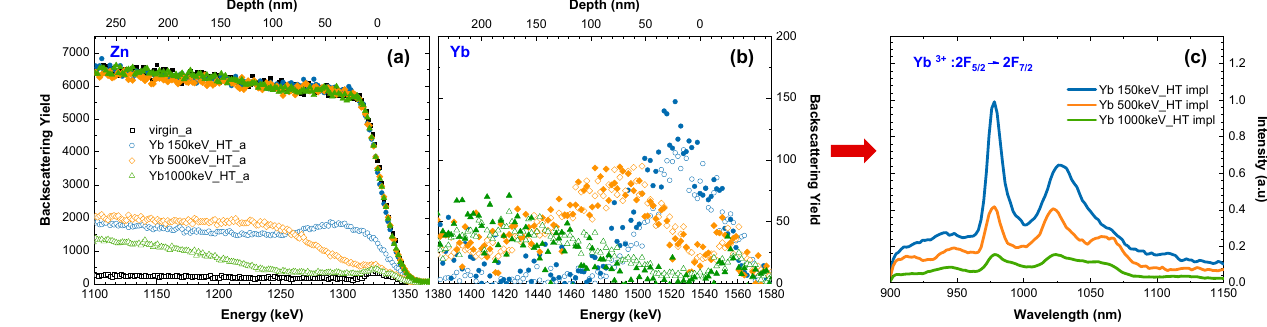
Figure 4. Random (solid symbols) and aligned (open symbols) RBS spectra ( a , b ) obtained for ZnO implanted with different energies of Yb ions at the fluence of 1 × 10 15 /cm 2 at 600 ◦ C. The corresponding PL spectra ( c ).